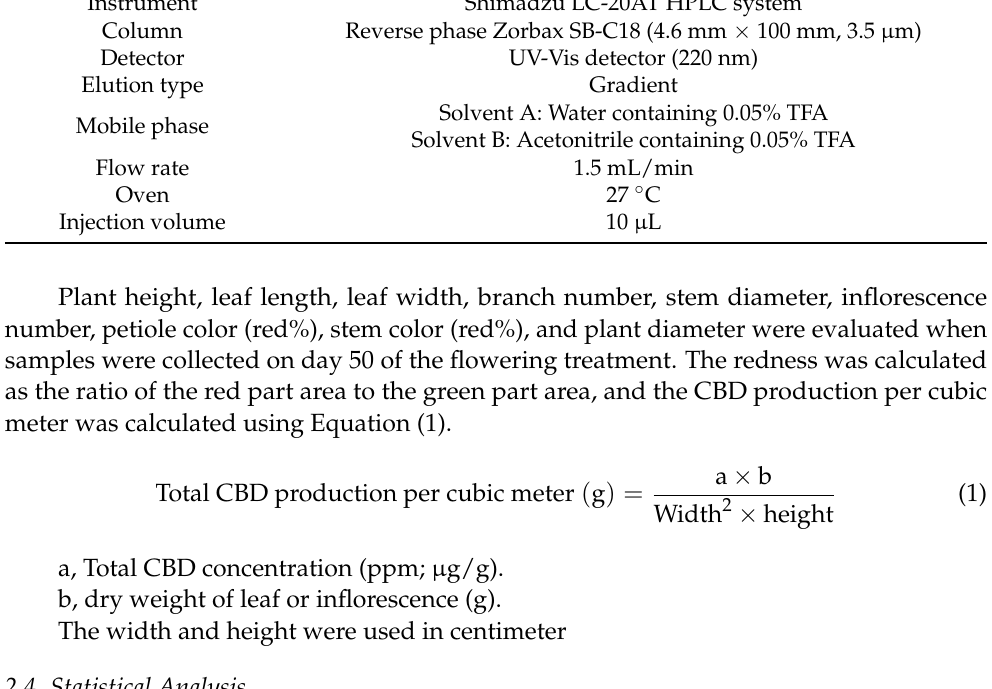
Table 2. HPLC conditions.